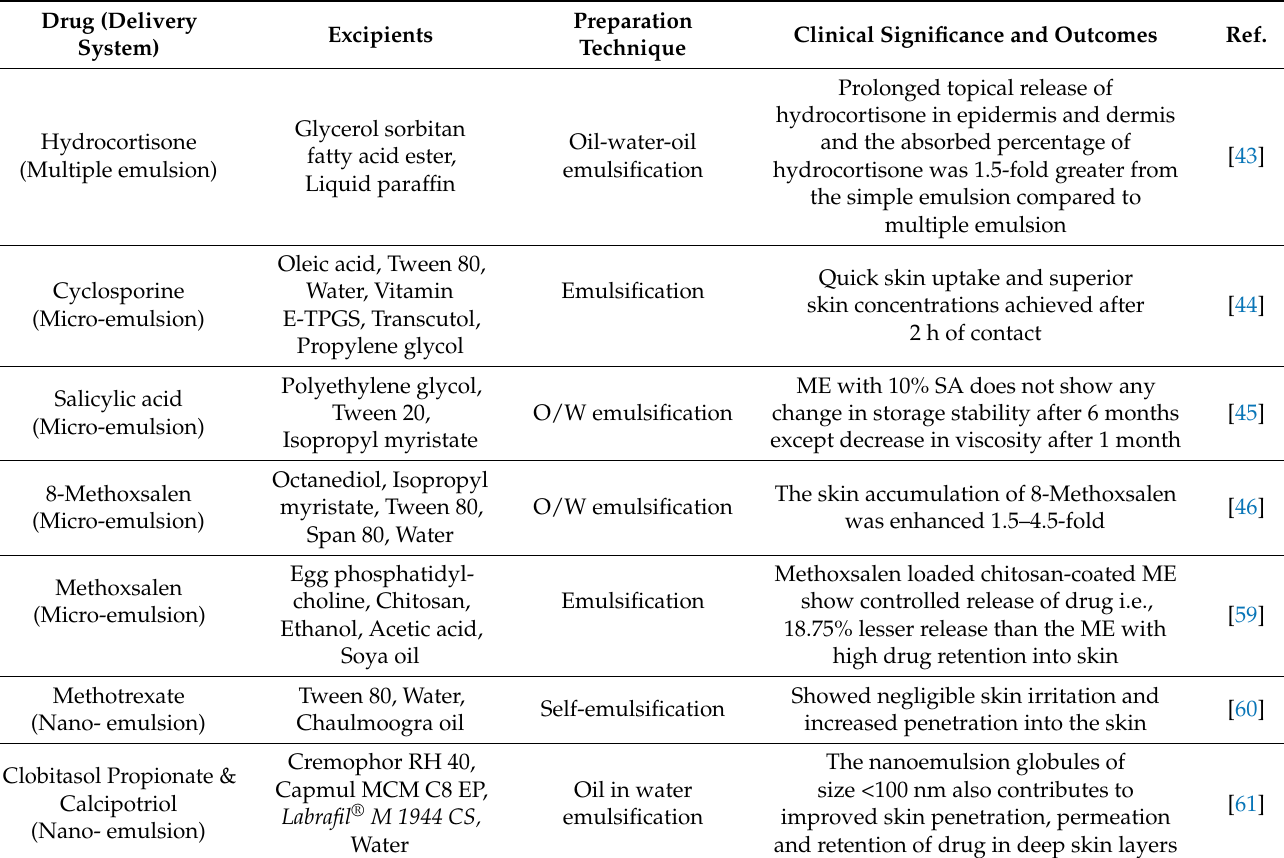
Table 5. Recent studies in emulsion drug delivery system for psoriasis